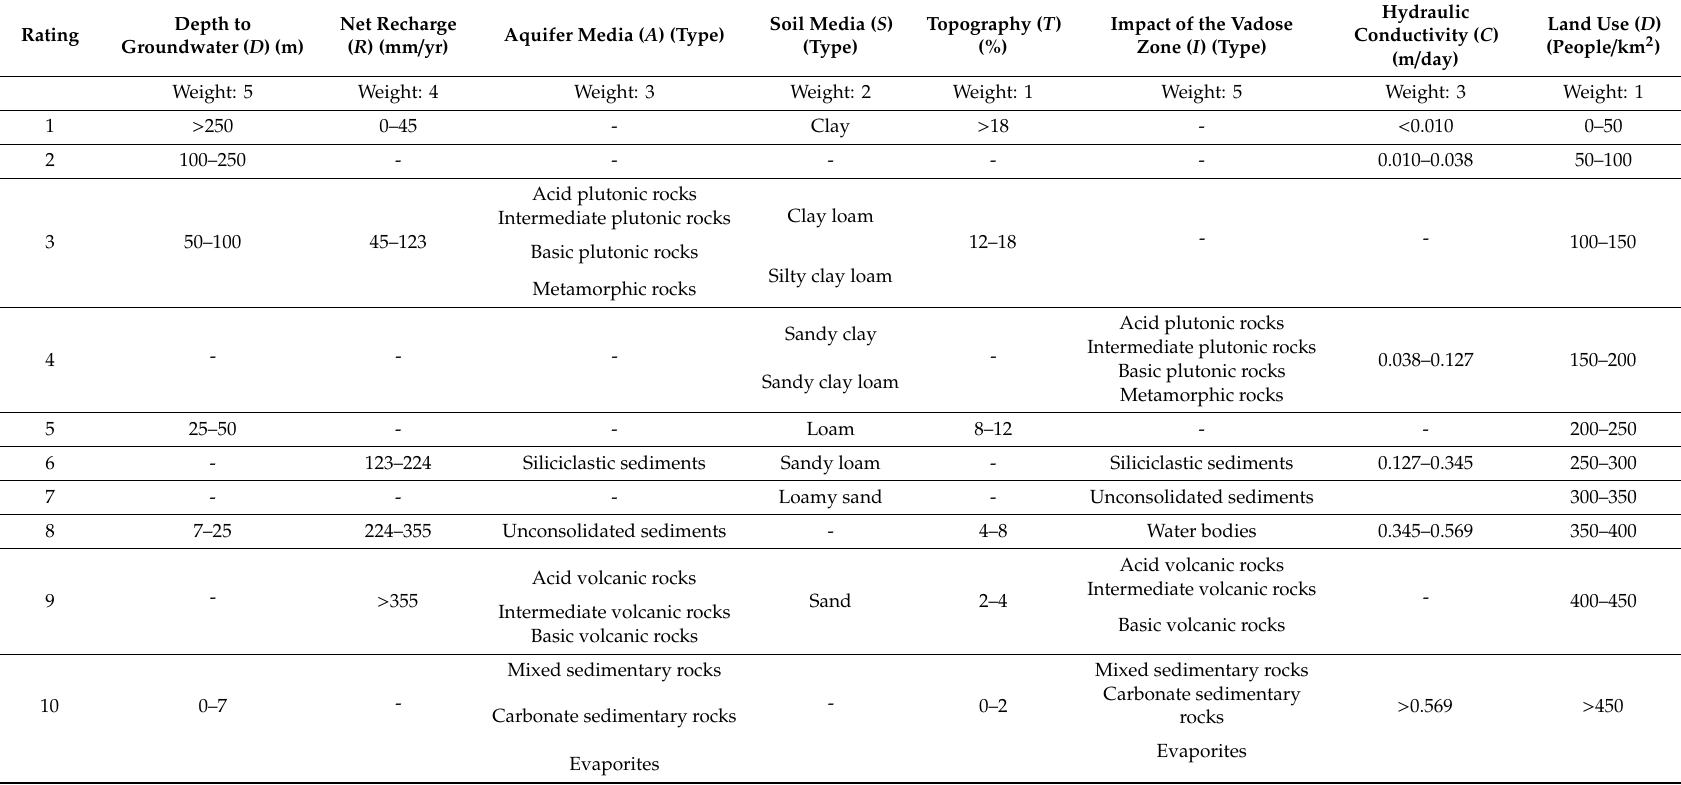
Table 2. Weight, range and rating of the DRASTIC parameters and land-use parameter (based on